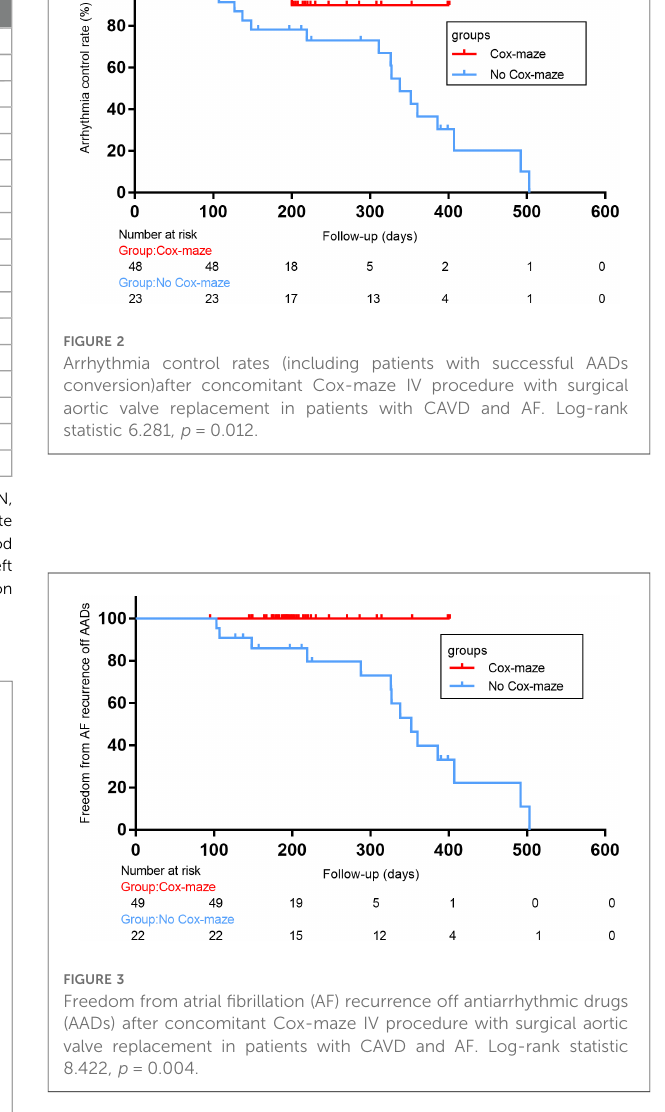
TABLE 3 Comparison of characteristics in follow-up between two groups. Follow-up data